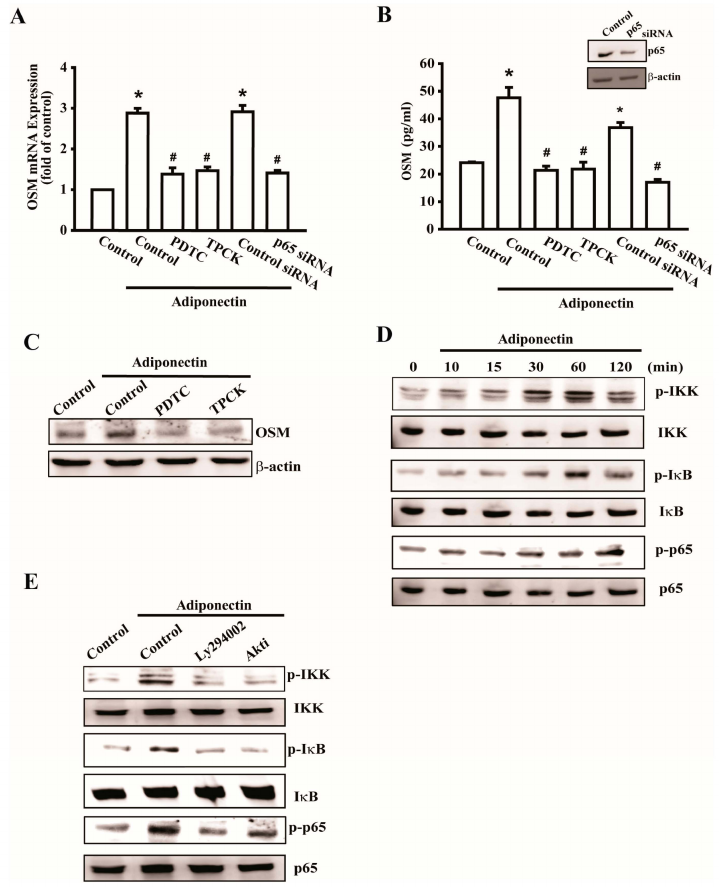
Figure 4. Adiponectin increases OSM expression through nuclear factor- κ B (NF- κ B) pathway. ( A ) Osteoblasts were pretreated with pyrrolidine dithiocarbamate (PDTC) (10 µ M) and N-tosyl-L-phenylalanine chloromethyl ketone (TPCK) (10 µ M) or transfected with p65 siRNA (0.5 nM) followed by stimulation with adiponectin (100 ng/mL), the mRNA expression of OSM were analyzed by qPCR ( n = 5); ( B ) Cells were transfected with p65 siRNA for 24 h, the protein level of p65 was measured by Western blot (upper-panel), and supernatant medium was collected to measure OSM expression by ELISA assay (lower-panel) ( n = 5); ( C ) Cells were pretreated with PDTC and TPCK for 30 min followed by stimulation with adiponectin (100 ng/mL), the protein level of OSM was measured by Western blot ( n = 6); ( D ) Cells were incubated with adiponectin in time intervals, and phosphate-IKK, -I κ B, and -p65 expression were investigated by Western blot ( n = 5); ( E ) Cells were pretreated with PI3K inhibitor, LY294002 (10 µ M), or Akt inhibitor (20 µ M) for 30 min followed by stimulation with adiponectin (100 ng/mL), phosphate-IKK, -I κ B, and -p65 expression were investigated by Western blot ( n = 6). Results are expressed as mean ˘ standard error of mean S.E.M. *, p < 0.05 compared with control; # , p < 0.05 compared with adiponectin-treated